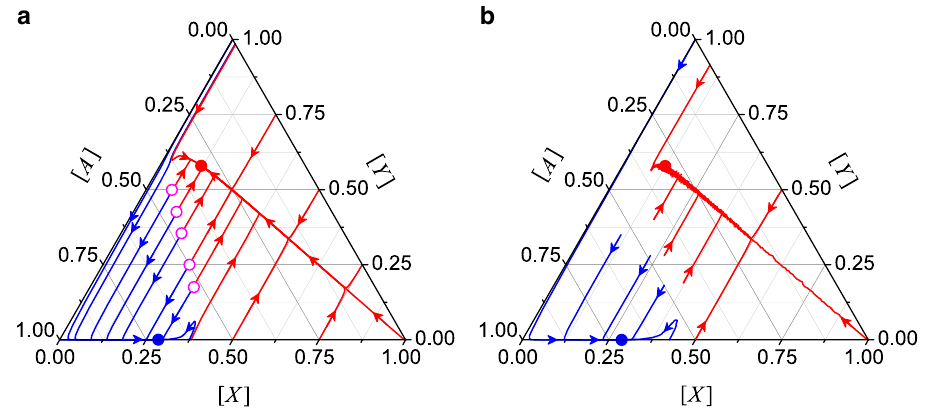
Fig. 3 Evolutionary properties of MR dynamics. The dynamical process can be represented as a fl ow diagram with the lines showing how the fractions of [ X ], [ Y ], and [ A ] evolve in time. The solid circles are the fi xed points that the system will fi nally evolve into. a Theoretical calculations based on the mean- fi eld theory. The open circles trace out a separatrix, with systems on different sides evolving into different fi xed points. b Simulation results. The system parameters are β 1 = 0.004, β 2 = 2.0, μ 1 = 0.01, and μ 2 =